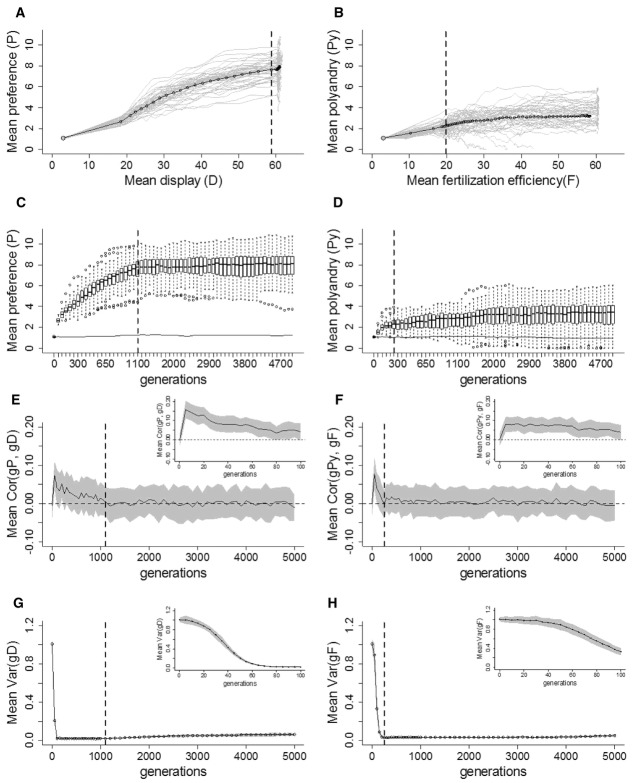
Coevolution of preference (P) and display (D; A, C, E, G), and of polyandry (Py) and fertilization efficiency (F; B, D, F, H), in the absence of costs. (A and B) Overall mean phenotypic trait values (black lines), mean values for individual replicate simulations (gray lines), and simulation starting values (gray circles) for (A) preference and display, and (B) polyandry and fertilization efficiency. (C and D) Evolutionary trajectories of P and Py across generations described as medians (black bands), first and third quartiles (box limits), and approximately twice the standard deviation (whiskers). Black lines show the mean values of “neutral” traits subject only to mutation. (E and F) Mean correlation (black lines) ± standard deviation (gray shading) between the genotypic values for preference, gP, and display, gD [Cor(gP,gD)]; and for polyandry, gPy, and fertilization efficiency, gF [Cor(gPy,gF)]. Dashed horizontal lines demarcate zero correlation. (G and H) Mean genotypic variances in D and F (black lines) ± SD (gray shading). (E–H) Inserts: Same correlations and variances in the first 100 generations at five generation intervals. All means are averaged over 50 replicate simulations and plotted every 50 generations until generation 1000 and 100 generations thereafter. In all plots, dashed vertical lines indicate when the mean genetic correlation went to zero.